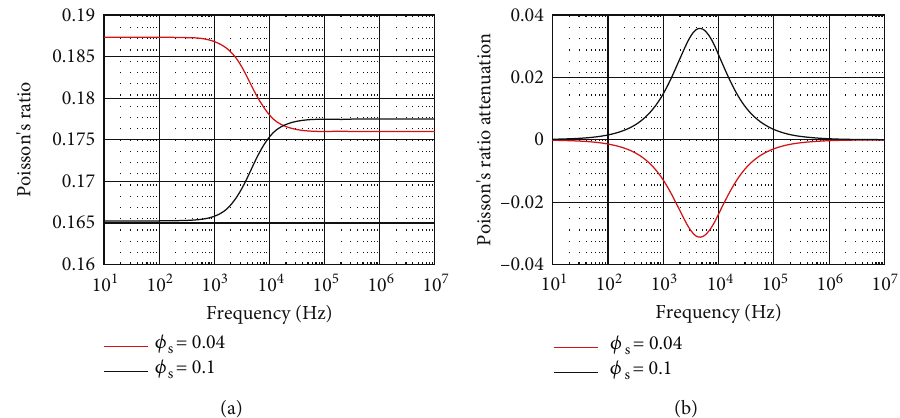
Figure 2: Modelling the frequency-dependent Poisson ’ s ratio and its attenuation from undrained state to unrelaxed state with the viscoelastic Zener model.